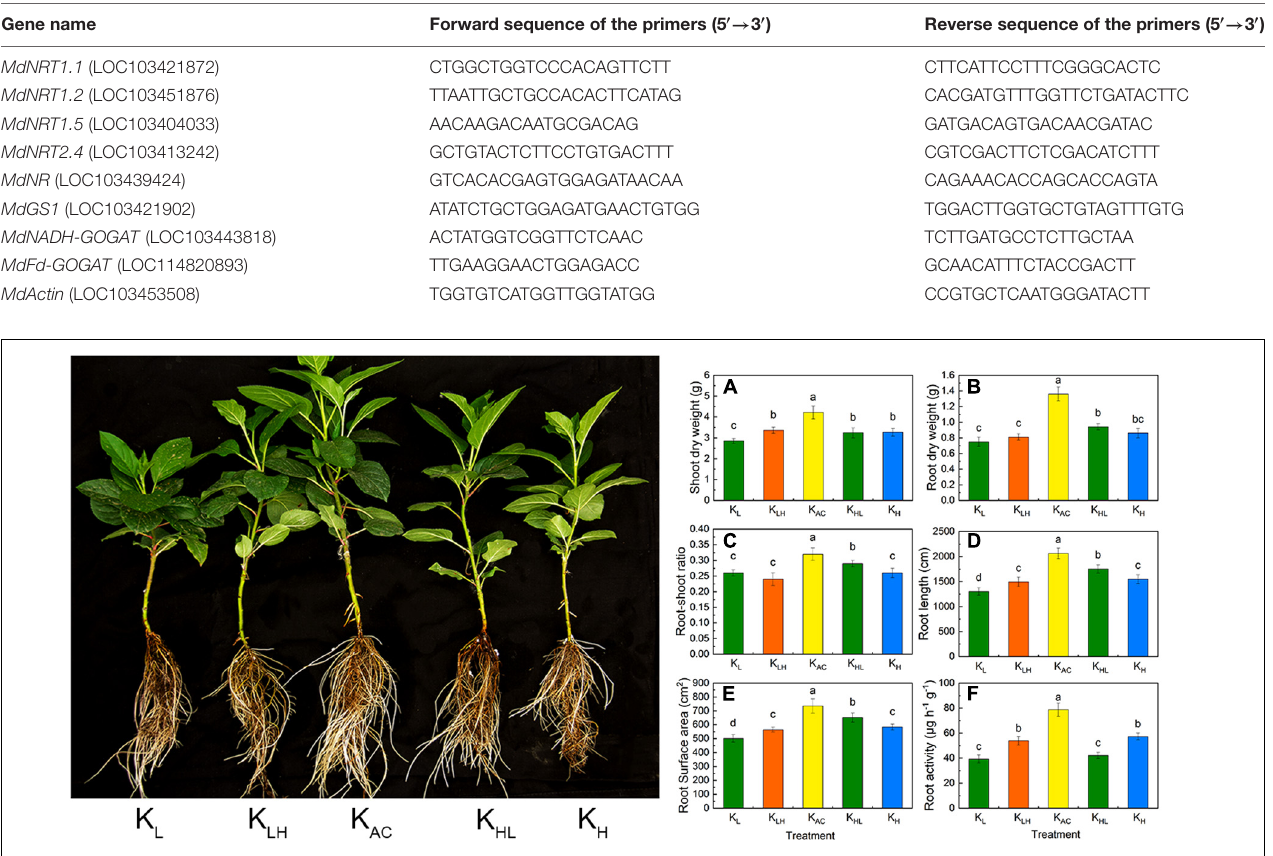
FIGURE 1 | Shoot dry weight (A) , root dry weight (B) , root-shoot ratio (C) , root length (D) , root surface area (E) and root activity (F) of M9T337 rootstocks treated with different K treatment. Data show the means ± standard deviation of three independent samples. Different letters on vertical bars indicate significant differences ( P <